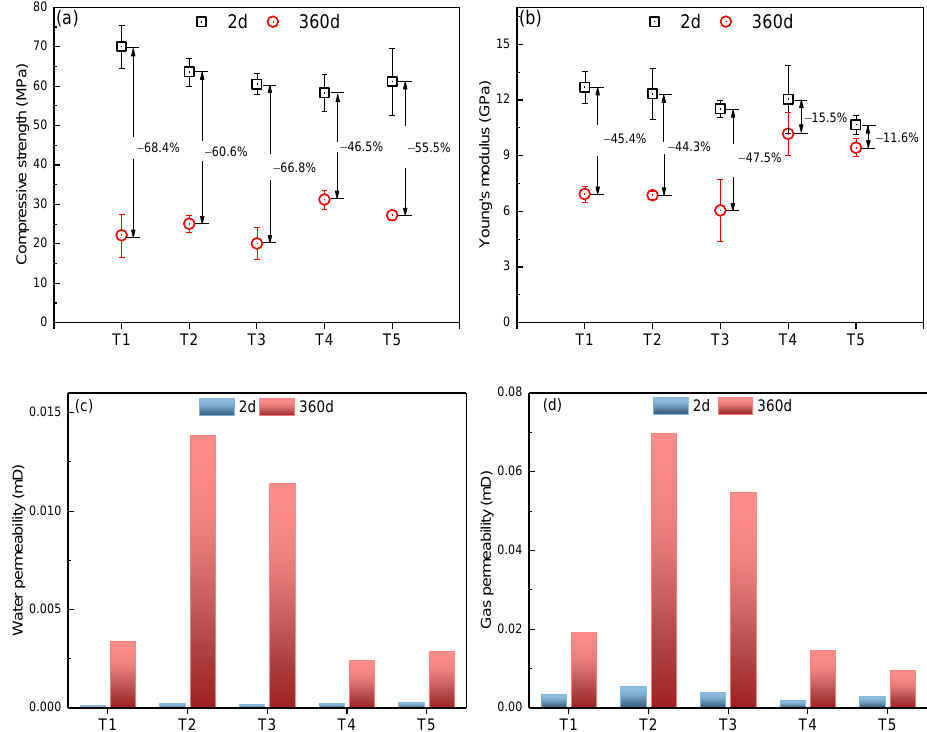
Figure 4. Long-term macroscopic property of slurries T1 to T5 cured under 200 °C and 150 MPa showed decreasing strength and modulus as well as increasing water/gas permeability from 2 to 360 d: ( a ) compressive strength; ( b ) Young’s modulus; ( c ) water permeability; ( d ) gas permeability.